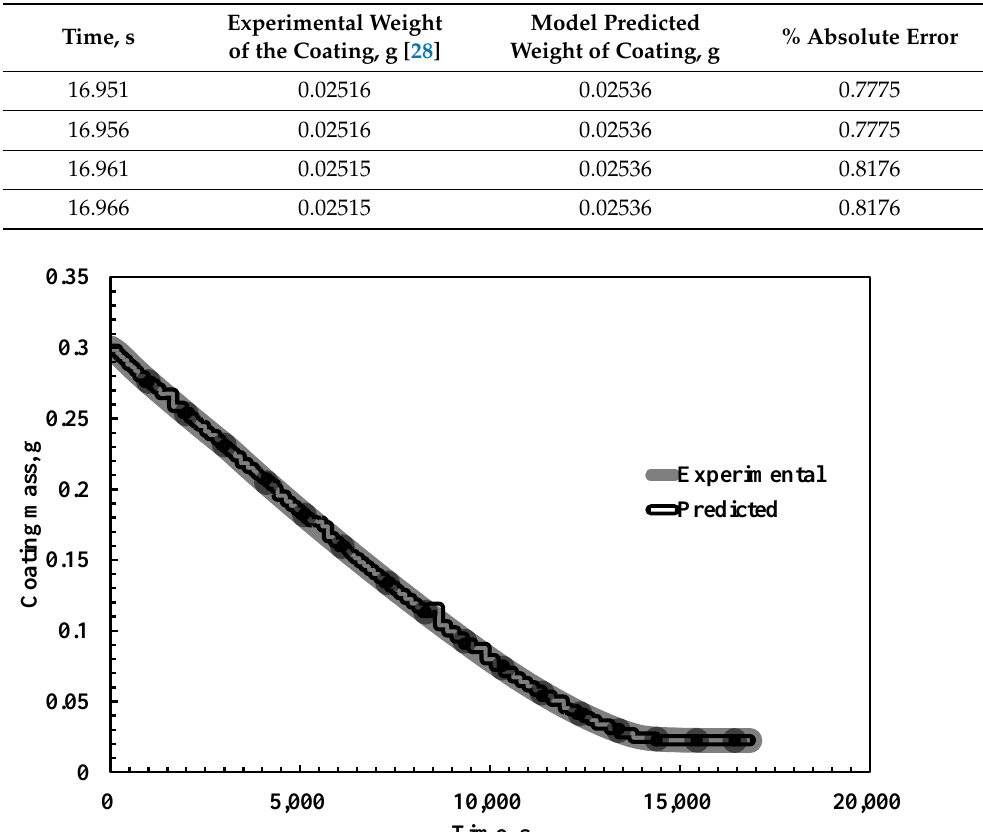
Figure 3. Comparison of model prediction with the experimental values for coating having 2021 micron initial coating thickness having poly(styrene) , p -xylene, and TPP , 4.95 %, 95.05%, and 0% respectively.